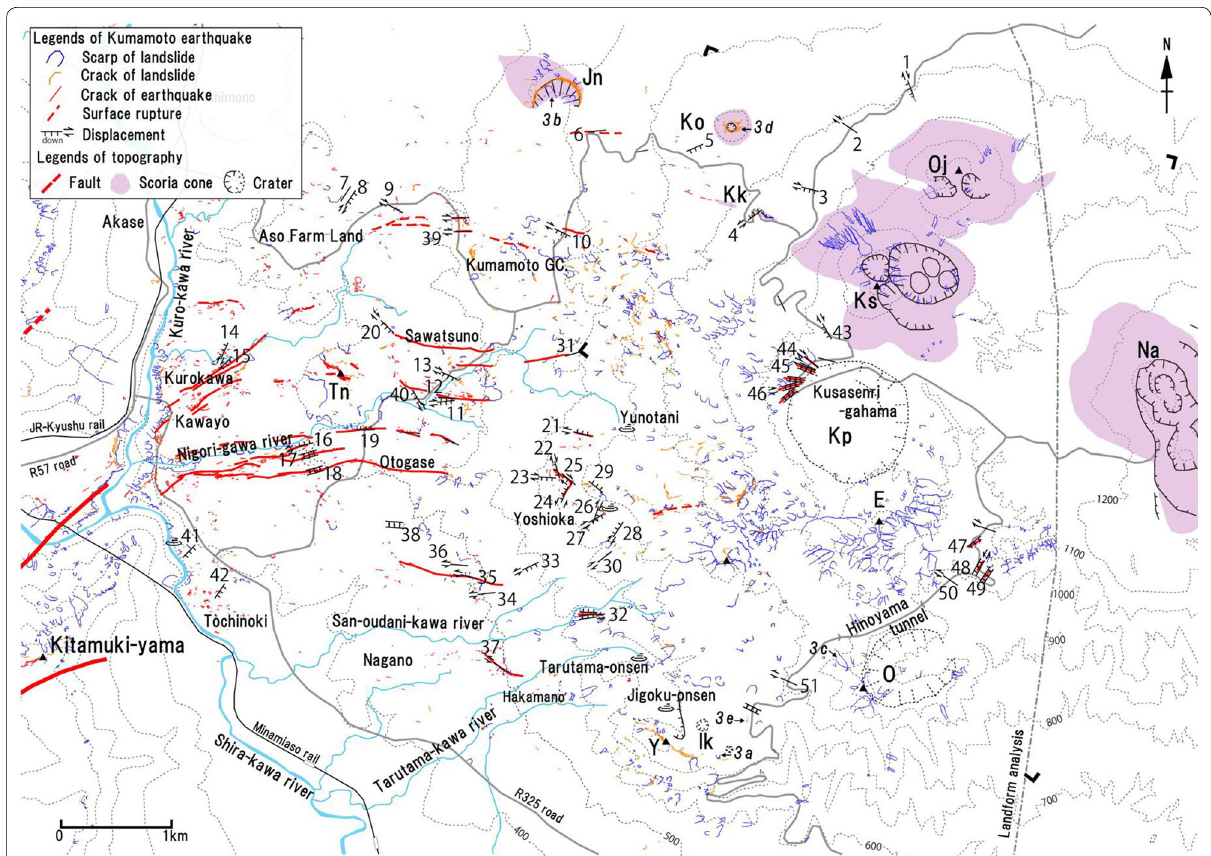
Fig. 2 Distribution of ruptures, cracks, and scarps created by Kumamoto earthquakes. Thick red lines around Kitamukiyama show active faults following Ono and Watanabe (1985). The black line ( dashed ) of craters denotes younger (older) craters of about 2–10 ky (Ono and Watanabe 1985; Miyabuchi and Watanabe 1997, 2000). 3a – 3e indicate locations of landslides shown in Fig. 3. The abbreviations of volcanic names are the same as those shown in Fig. 1. Ik, Ikenokubo and Jigoku craters. L marks denote areas of aerial views in Fig.